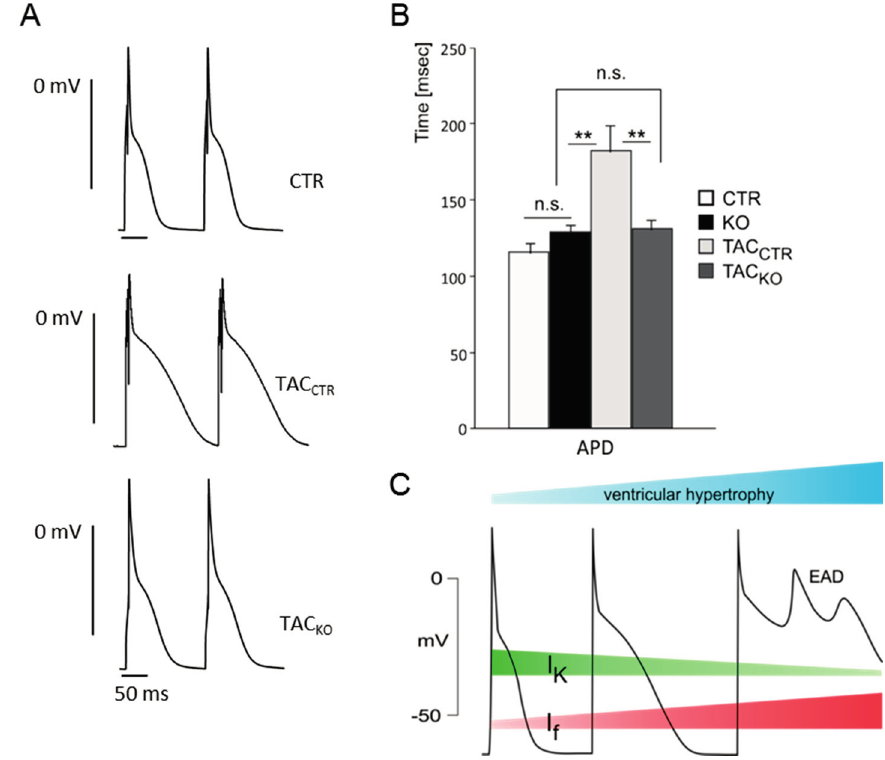
Figure 1. Mice lacking hyperpolarization-activated cyclic nucleotide-gated (HCN) 2+4 channels do not develop a significant prolongation of the action potential during ventricular hypertrophy. ( A ) Action potentials of ventricular myocytes isolated from control (CTR), hypertrophic control (TAC CTR ) and hypertrophic HCN2+4 knockout (TAC KO ) mice. Ventricular hypertrophy was induced by the transverse aortic constriction procedure (TAC); ( B ) Mean action potential durations (APD) of ventricular myocytes from controls (CTR, white), HCN2+4 knockouts (KO, black), hypertrophic controls (TAC CTR , light grey) and hypertrophic HCN2+4 knockouts (TAC KO , dark grey). n.s. means p > 0.05, ** p < 0.01. ( A ) and ( B ) are taken from Hofmann, F. et al. [46]; ( C ) During ventricular hypertrophy, an increased activity of HCN channels, together with a decrease in potassium currents, counteracts the repolarization of the action potential. The resulting action potential prolongation increases the risk of early after depolarizations (EAD) which are an important cause of lethal ventricular arrhythmias. The diagram is partly based on [61]. I f and I K are indicated by red and green stripes, respectivley. The development of ventricular hypertrophy is indicated by the bluish stripe at the top of the diagram. Remarkably, this concept is not limited to conditions of ventricular hypertrophy where ventricular